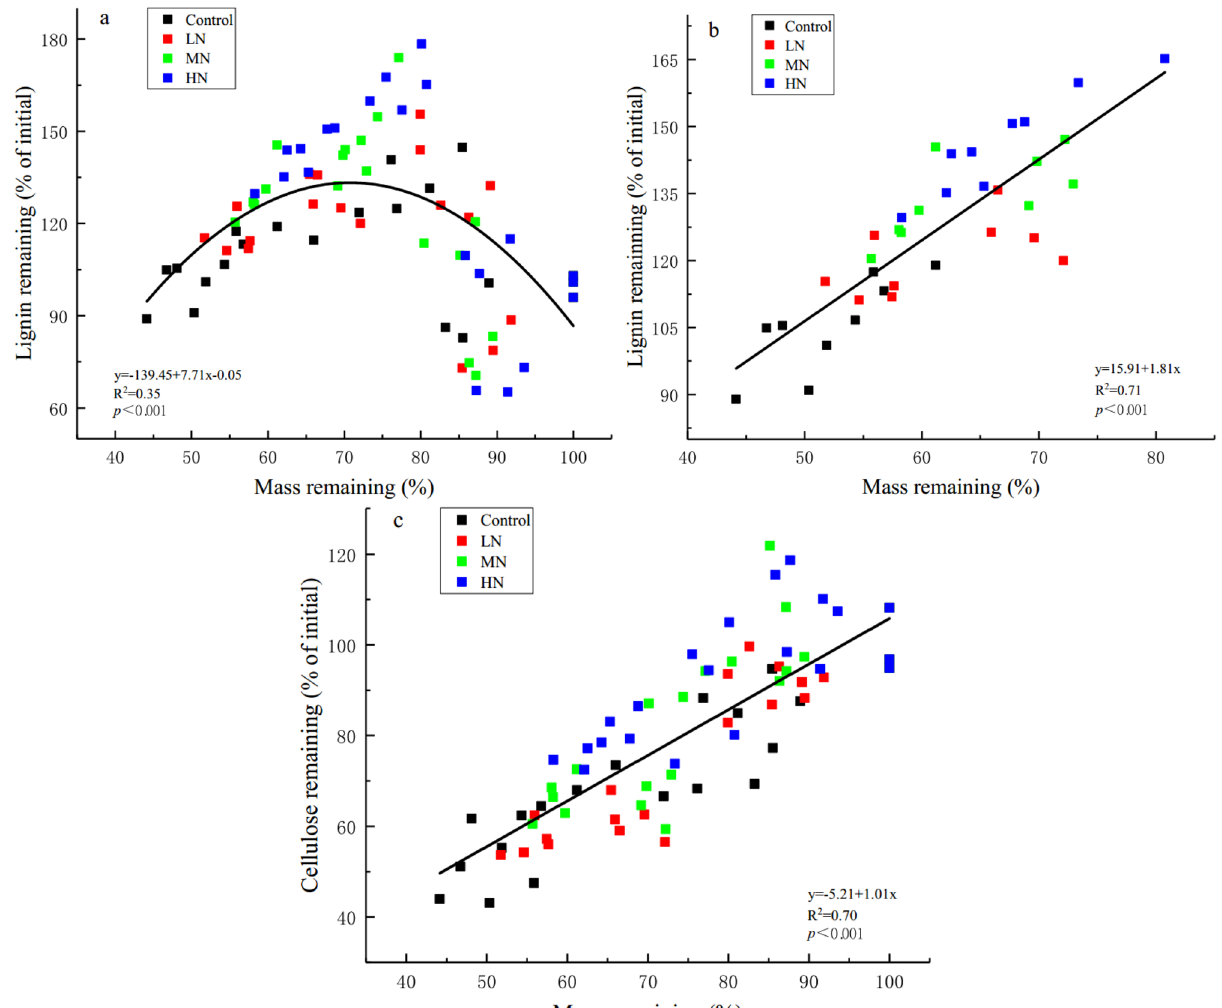
Figure 3. Relationships between the proportion of mass remaining and those of lignin and cellulose remaining. ( a ) Relationship between the proportions of mass remaining and lignin remaining over the experimental period; ( b ) relationship between the proportions of mass remaining and lignin remaining after 6 months of decomposition; ( c ) relationship between the proportions of mass remaining and cellulose remaining over the experimental period. Each point denotes the mean value of three litterbags at each sampling time for each